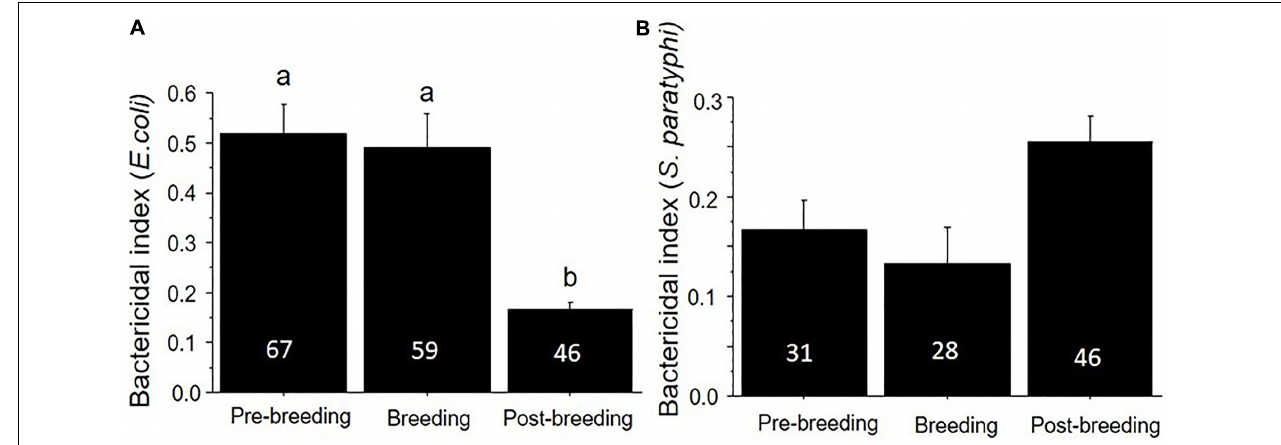
FIGURE 3 | Bactericidal capacity (mean ± SE) against (A) E. coli and (B) S. paratyphi in plasma collected from birds in the pre-breeding, breeding, and post-breeding seasons. Numbers in the bars indicate sample sizes and different letters above bars indicate significant differences. Urban and natural populations were combined in these figures.